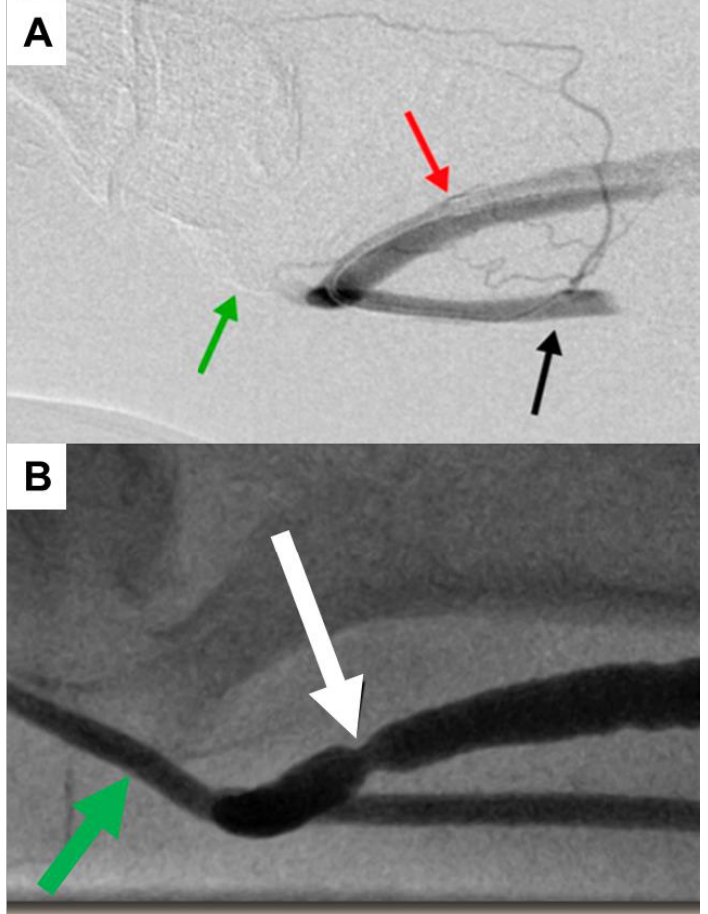
Figure 6. Pre- and post-procedural angiographic images of an arteriovenous graft (AVG) following minimally invasive limited ligation endoluminal-assisted revision. ( A ) Pre-procedural imaging following brachial artery injection (black arrow) immediately proximal to the anastomosis of the AVG. Contrast is completely diverted into the AVG (red arrow), while no flow is seen distally into the artery (green arrow). ( B ) Post-procedural imaging shows a newly formed waist (white arrow) in the proximal AVG after the suture has been tied with redistribution of blood flow distally into the brachial artery (green arrow).